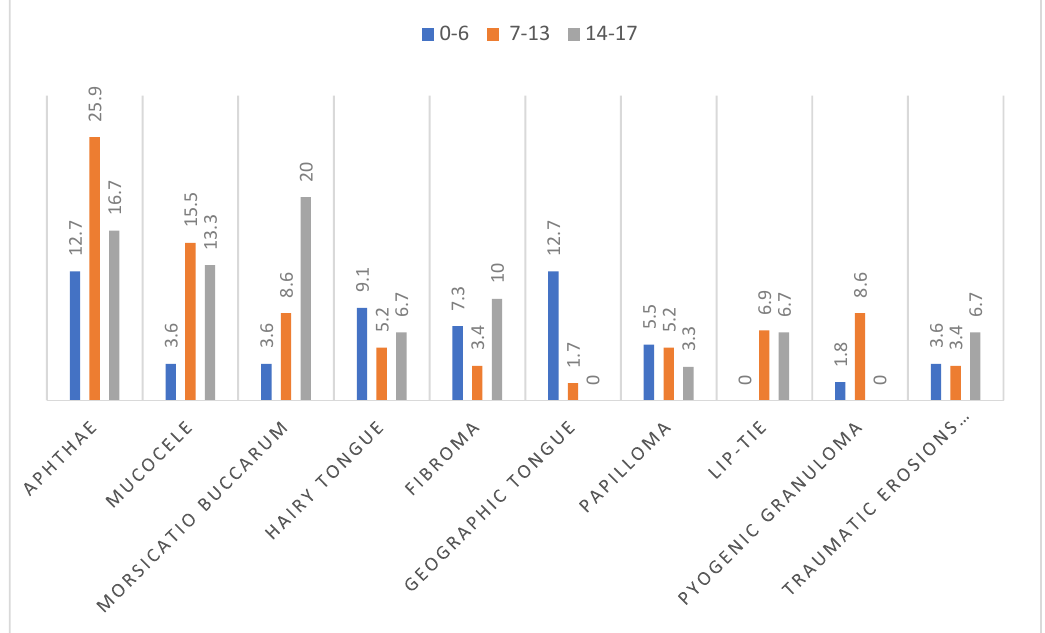
Figure 2 . Distribution of the 10 most common OMLs by age groups, in percentage. Figure 2. Distribution of the 10 most common OMLs by age groups, in